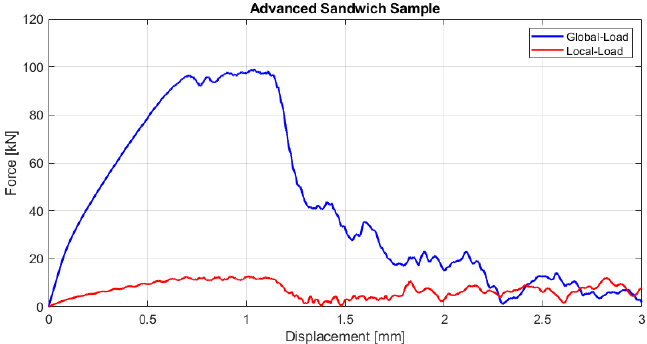
Figure 8. The characteristic force-displacement curve for the advanced composite joint.